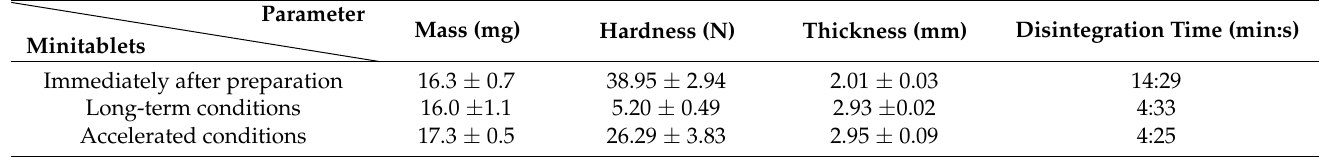
Table 3. Physical properties of minitablets analyzed immediately after preparation and after six